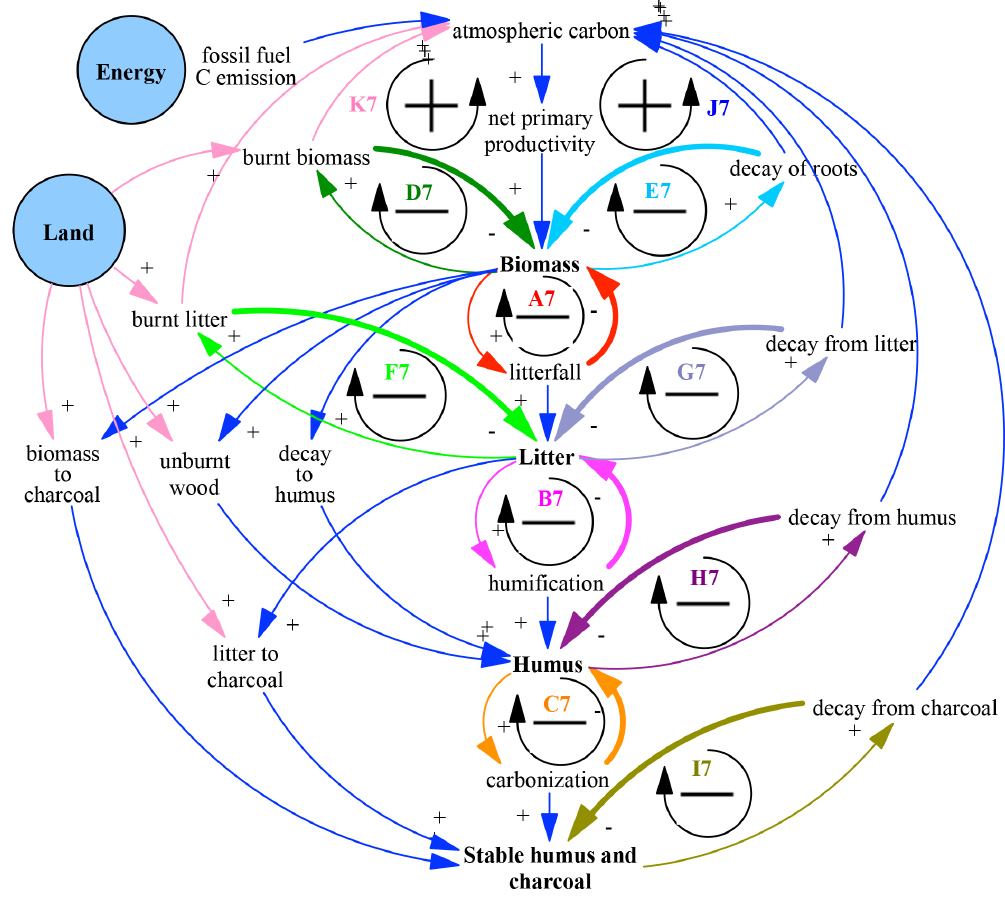
Figure 9. CLD in the carbon